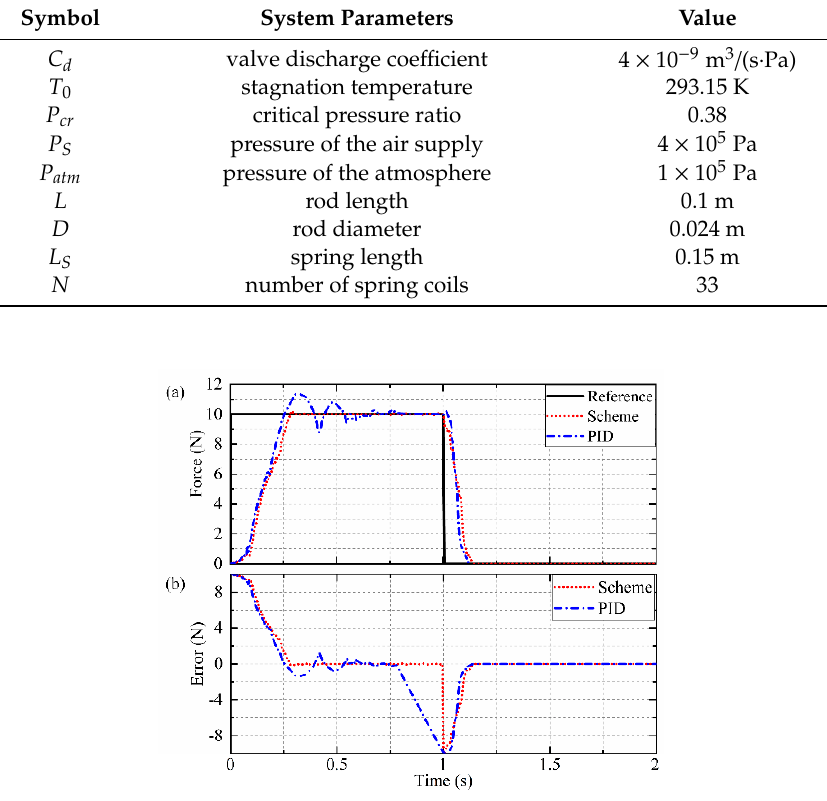
Figure 17. Experimental results of the step response for proposed scheme and conventional proportional–integral–derivative (PID) controller: ( a ) Force; ( b ) Force